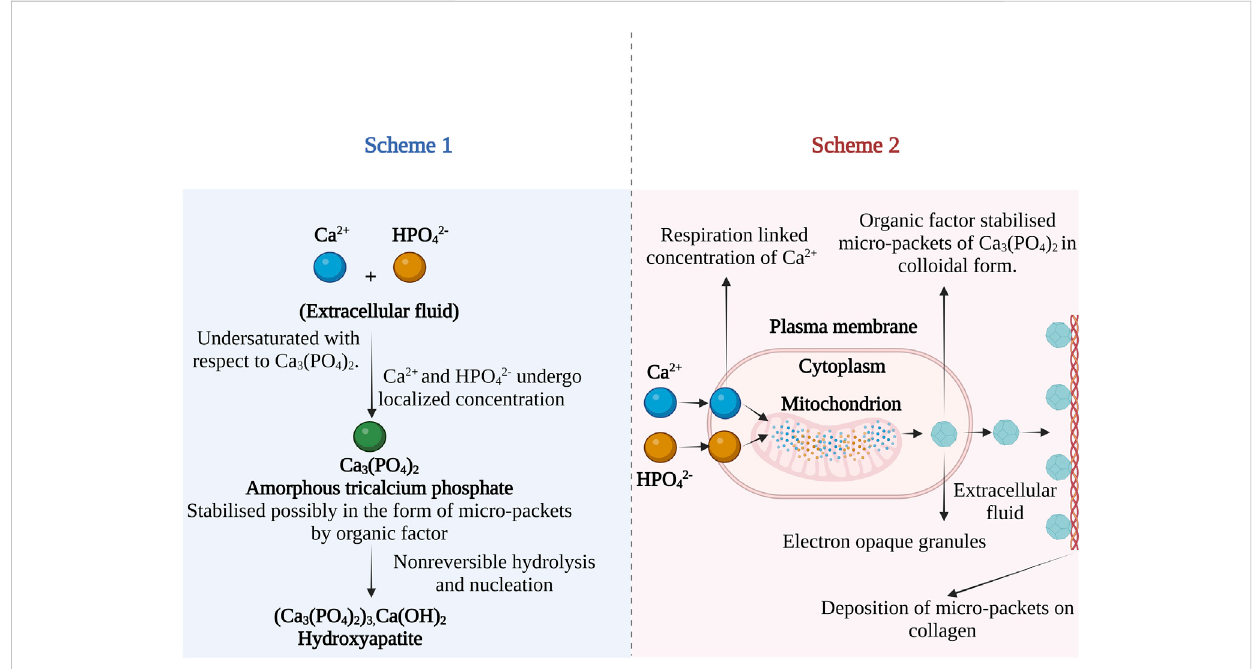
FIGURE 4 Possible mechanism of bone apatite formation from ACP in the presence of biological inhibitor. Scheme 1 — apatite formation mechanism in extracellular fl uid and Scheme 2 — mitochondrial-dependent cellular mechanism of bone apatite formation. The images are inspired by the fi fth jubilee lecture on mitochondria and calcium ion transport of (Lehninger, 1970).